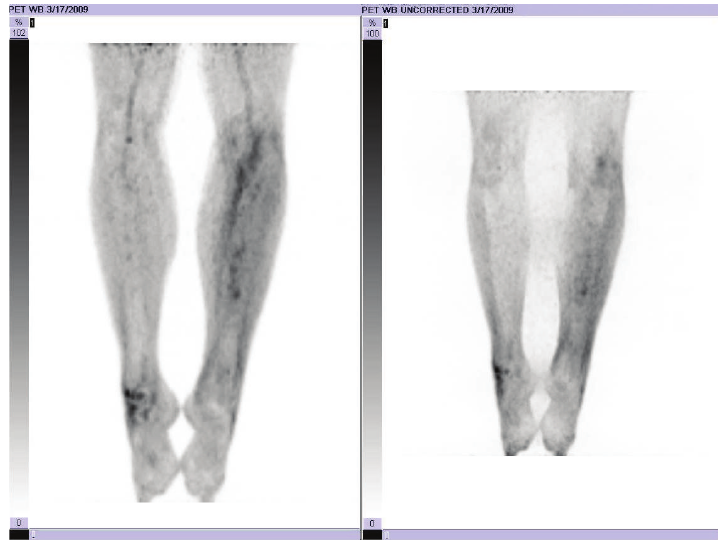
Figure 3: Postchemotherapy and radiotherapy planar PET/CT image.